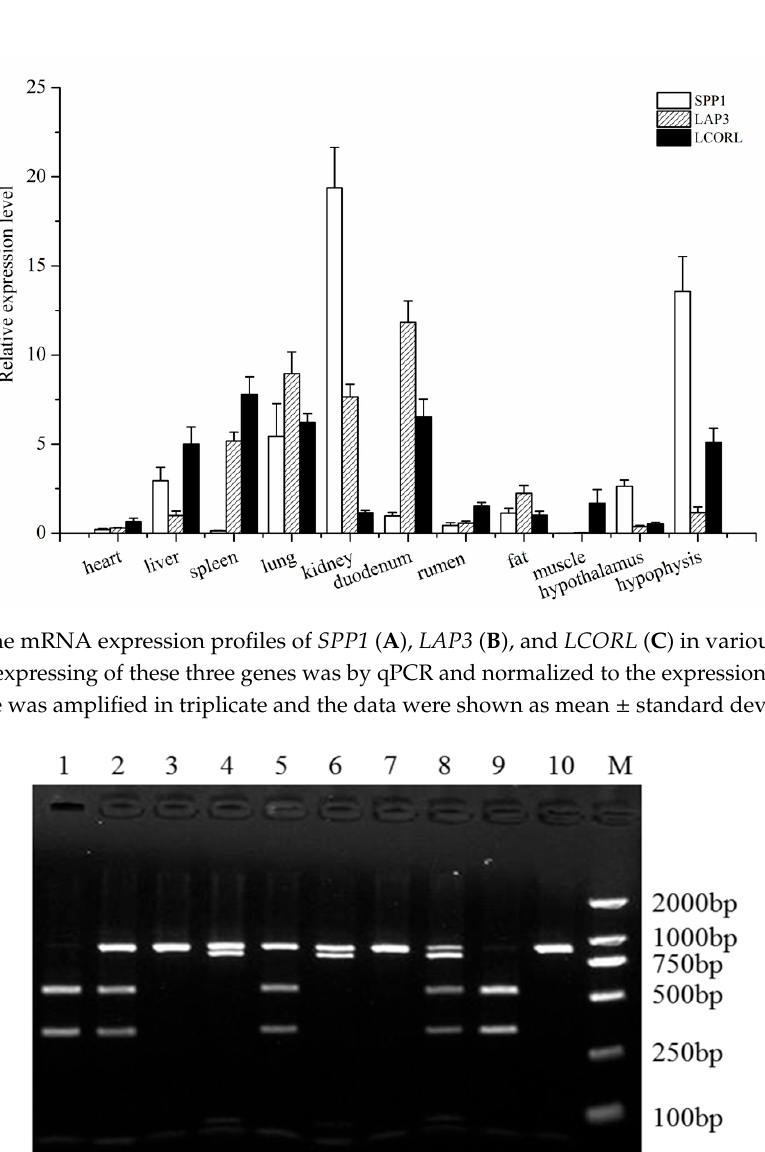
Figure 4. The PCR-RFLP results for the different genotypes of sheep LAP3 . The genotypes are marked at the top of the lanes. ( A ) The PCR products digested using AcuI show the different genotypes of LAP3 XM_012179698.3:c.232C>G mutation. ( B ) The PCR products digested using BccI show the different genotypes of LAP3 XM_012179698.3:c.1154C>T mutation. M: DNA Marker DL2000. We recorded two substitutions XM_027970888.1:c.-1096T>C and XM_027970888.1:c.2162A>C in sheep LCORL . For the first substitution, the length of the amplified fragment was 495 bp, with the nucleotide substitutions locating at 281 and 414 bp and fixed sequences TCAGA at 277-281 bp and TCGGA at 413-417 bp recognized by Hpy188I , which generated four fragments: 281 and 214 bp bands representing allele T, 281, 136 and 78 bp bands representing allele C (Figure S4). The